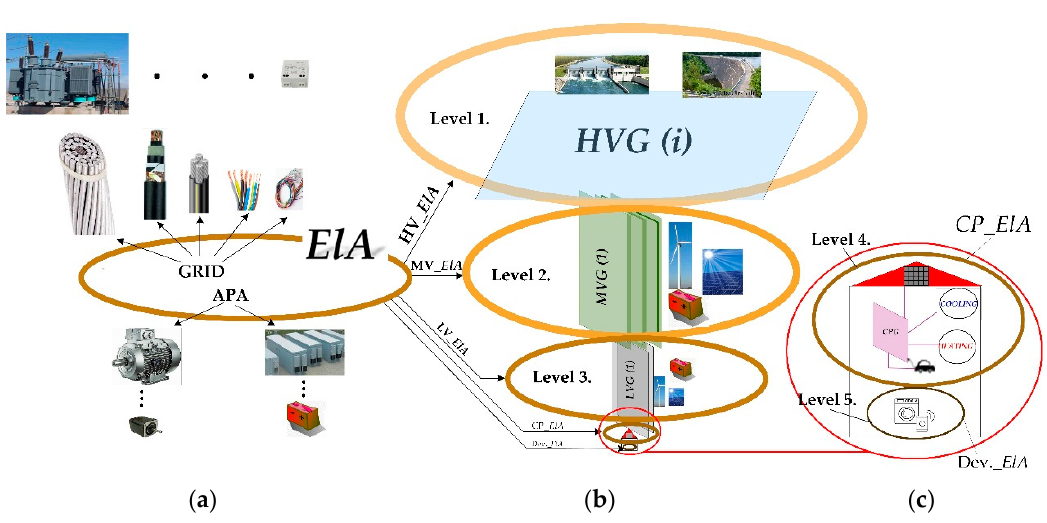
Figure 2. Link chain fractal of power systems: ( a ) The fractal pattern electrical appliances (ElA); ( b ) ElA in different fractal levels; ( c ) magnification of levels 4 and 5.